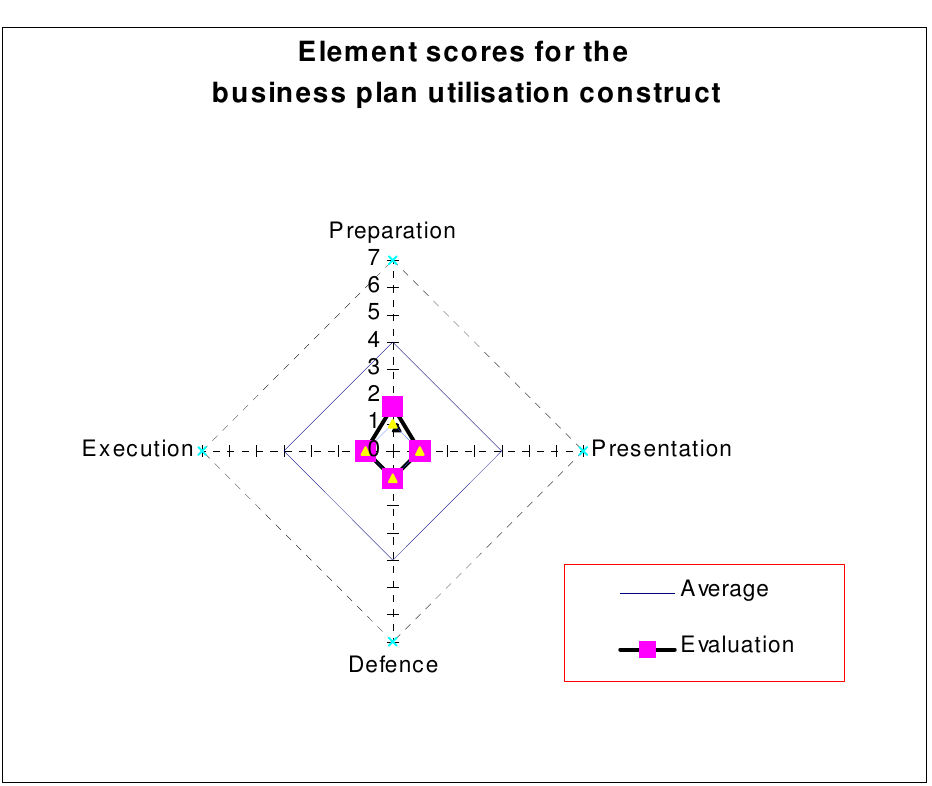
Figure 6: Assessment results for the business plan